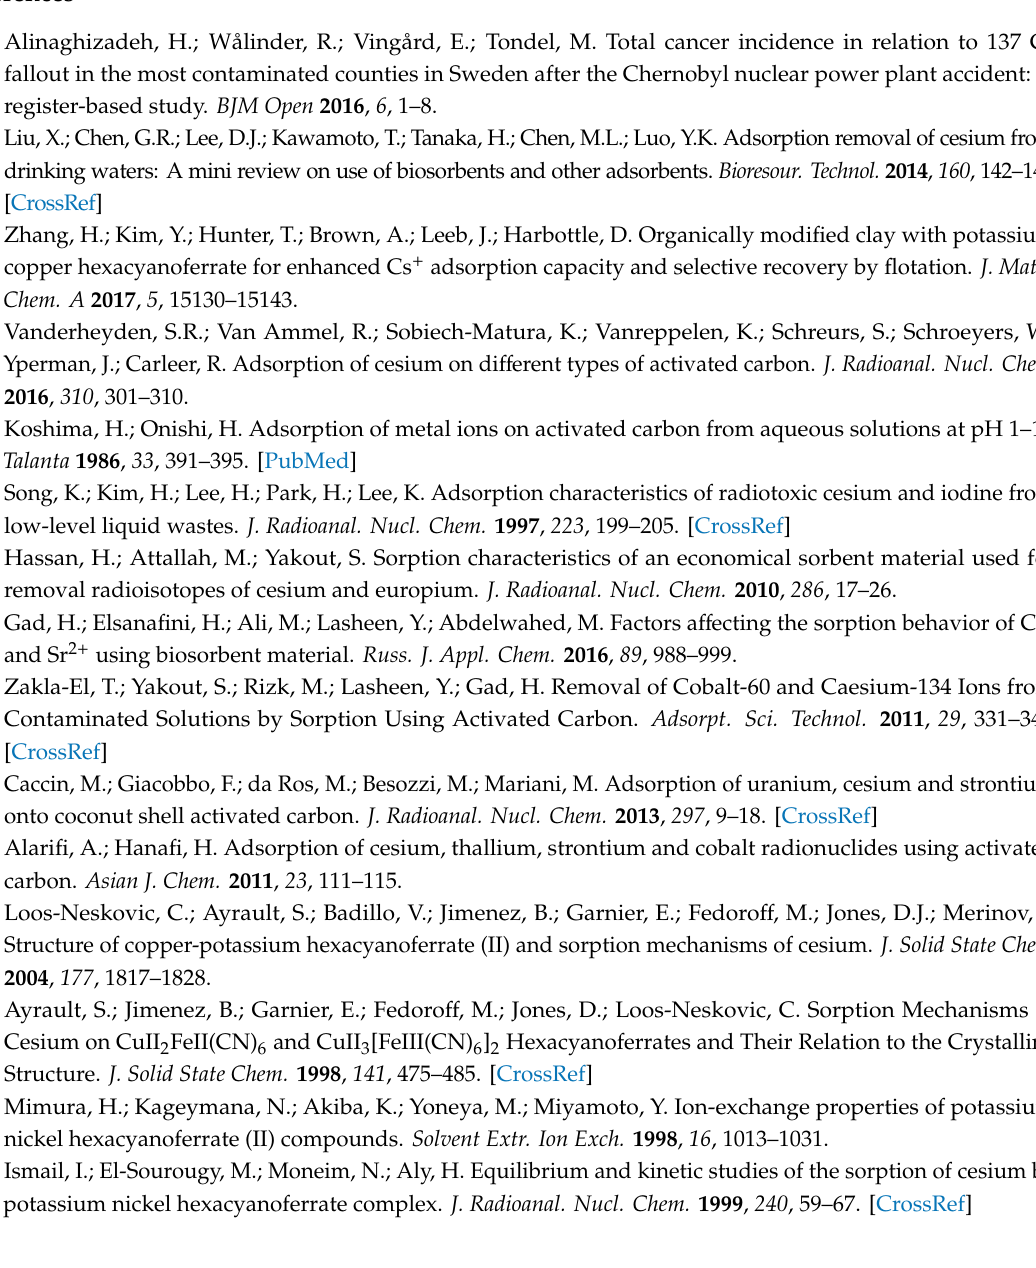
derivative weight loss; Figure S4: X-ray di ff ractograms of C / CuHCFe and Cox / CuHCFe. Vertical bars indicate peaks position of the related phase Cu 2 Fe(CN) 6 · 0.5H 2 O and K 2 Cu 3 [Fe(CN) 6 ] 2 ; Table S1: Atomic quantification of pristine C and